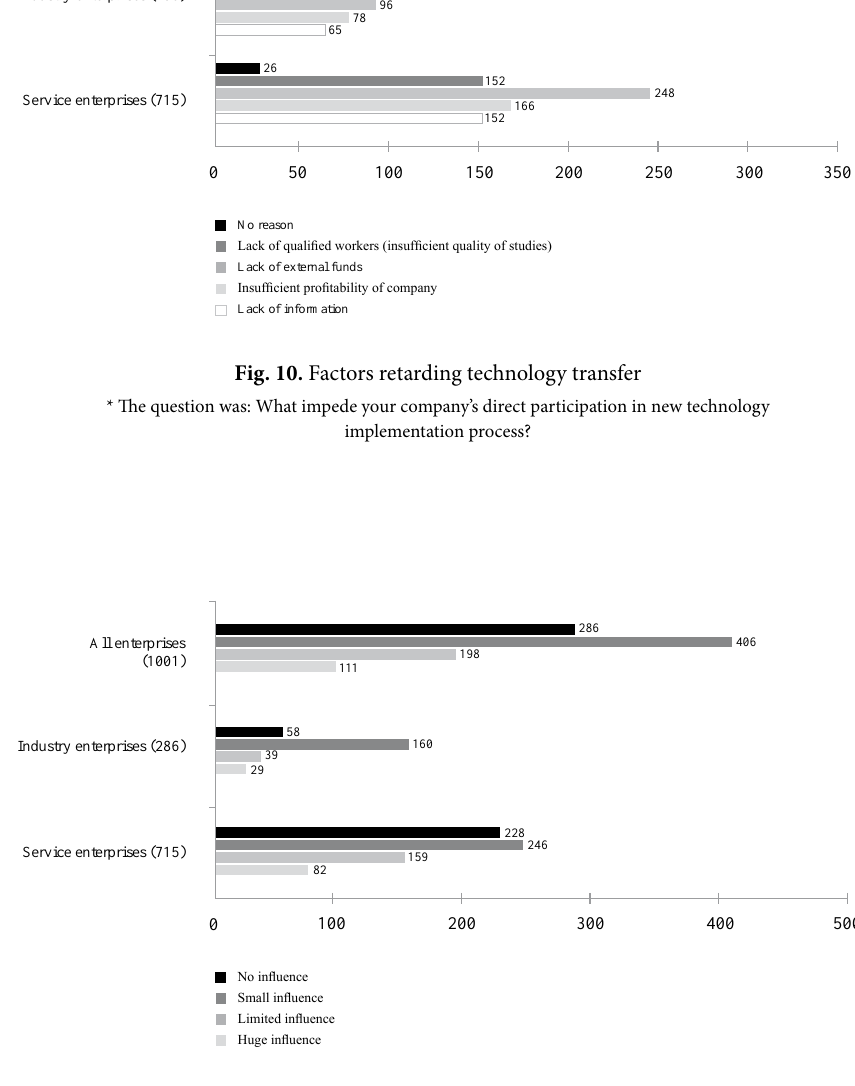
fig. 11. Role of government in implementation of new